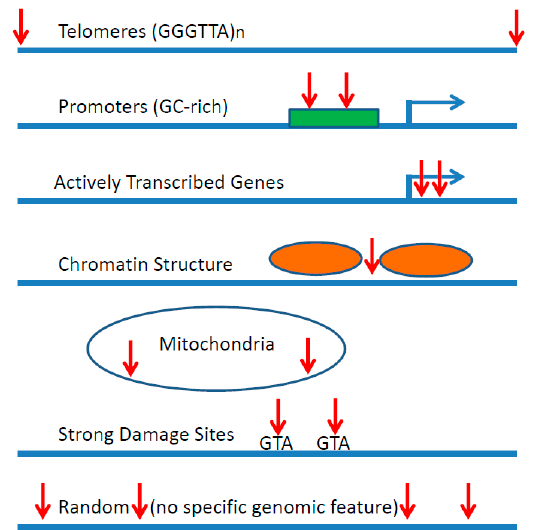
Figure 3. Sites of possible genomic cellular DNA damage by Bleomycin. Red arrows indicate bleomycin cleavage sites, while blue arrows are transcription start sites. The green rectangle is a promoter and the orange ovals are nucleosome cores.